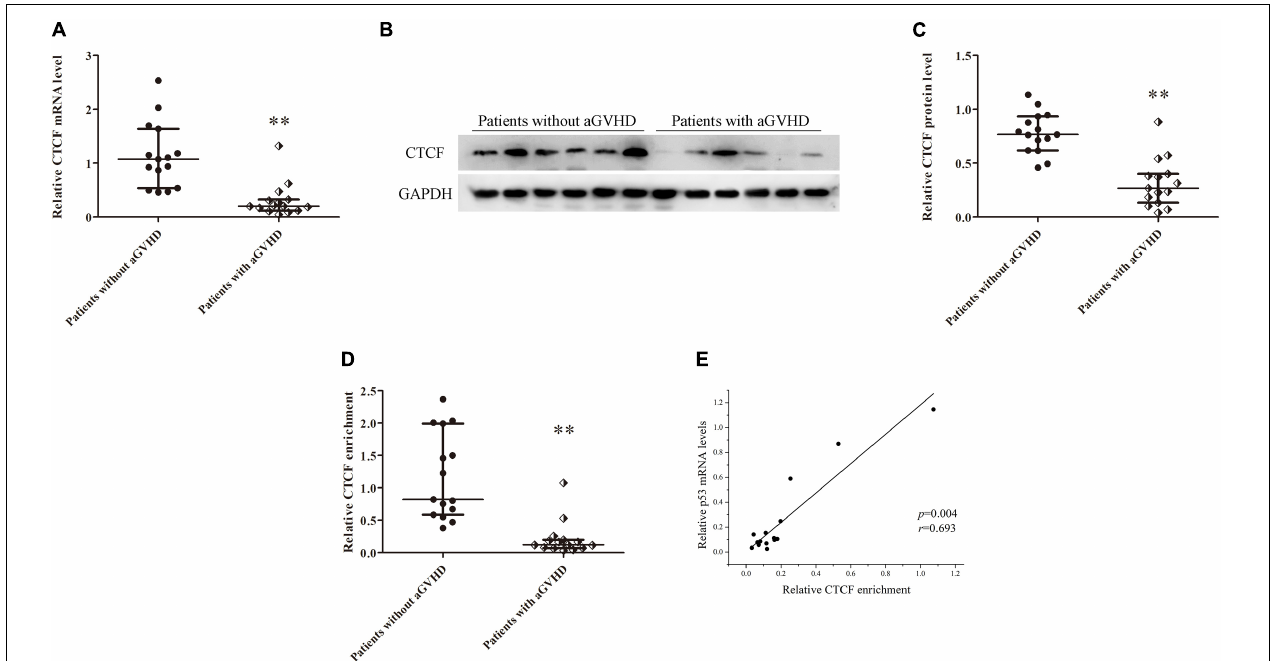
FIGURE 3 | CTCF downregulation results in low expression of p53 in CD4 + T cells from patients with aGVHD. (A) Relative mRNA levels of CTCF in CD4 + T cells from patients with aGVHD ( n = 15) and those without aGVHD ( n = 15), normalized to GAPDH. (B) Representative Western blotting results for CTCF protein expression in CD4 + T cells from patients with aGVHD ( n = 10) and those without aGVHD ( n = 10). (C) Quantitative analysis of band intensities for CTCF protein, normalized to GAPDH expression. (D) ChIP-qPCR analysis of CTCF enrichment in the p53 promoter in chromatin fractions extracted from CD4 + T cells from patients with aGVHD ( n = 15) and individuals without aGVHD ( n = 15). Values are relative to those obtained with input DNA prepared from untreated chromatin. (E) Correlation between CTCF enrichment and p53 mRNA levels in CD4 + T cells from aGVHD cases ( n = 15). ( ∗∗ P <